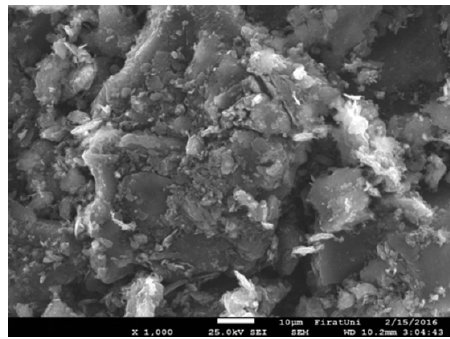
Fig. 1. SEM image of graphite